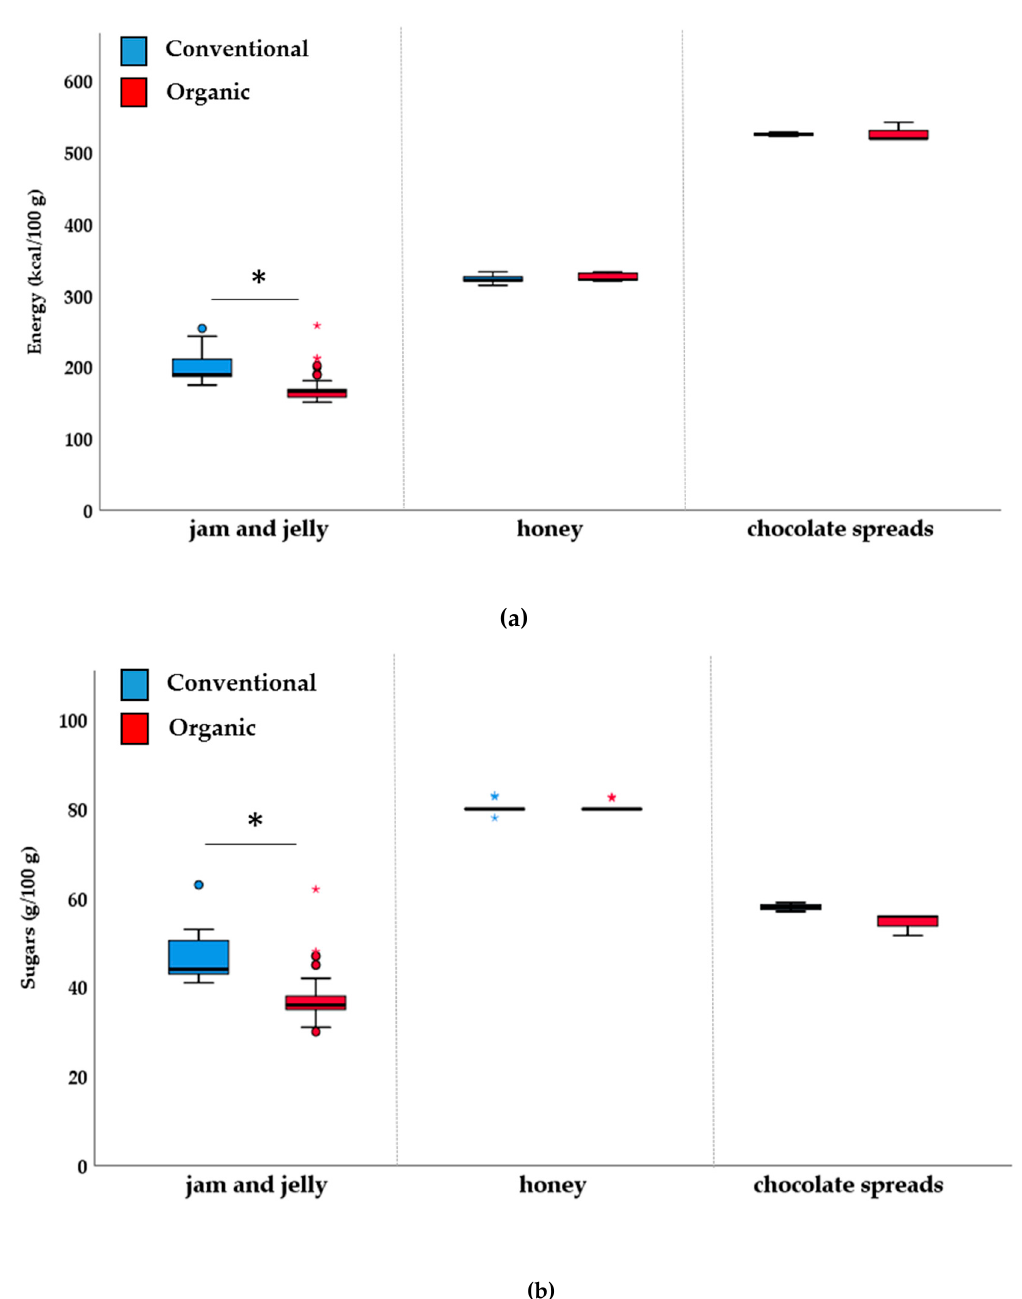
Figure 2. Box plot for energy (kcal / 100 g) ( a ) and sugars (g / 100 g) ( b ) of “jams, chocolate spreads and honey” category. * p < 0.05, Mann–Whitney non-parametric test for two independent samples.